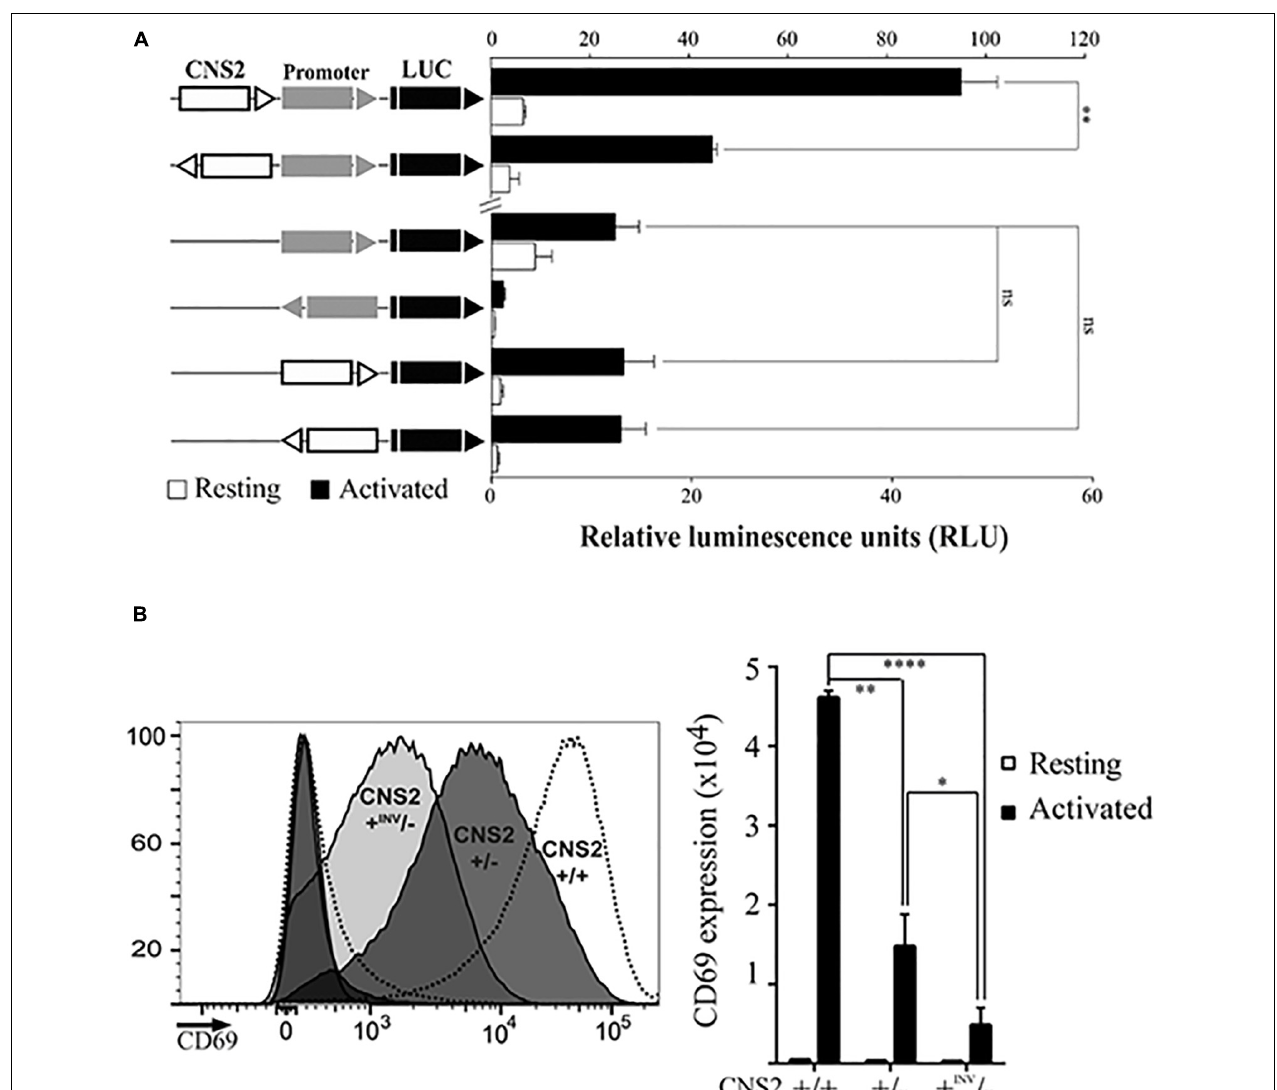
FIGURE 2 | CNS2 activity is partially orientation-independent. (A) Jurkat cells were transfected with luciferase constructs bearing the CD69 promoter and/or CNS2 regulatory elements in the indicated positions and orientations with respect to the luciferase ORF. Bars and error bars denote the mean ± standard error of the mean (SEM), respectively, of relative luminescence units from three individual experiments, being the value of each experiment the mean of two technical duplicates. (B) Left. Histograms of CD69 surface expression 24 h post-activation in representative CNS2 ± (dark gray) and CNS2 + inv /- (light gray) clones. Histograms of non-activated and activated wild type controls are represented as dashed lines. Right. MFI of CD69 surface expression in two independent CNS2 ± clones and four CNS2 inv /- clones in basal conditions (white) or 24 h post-activation (black). Mean ± SEM of CD69 MFI of the various assayed clones are shown. ns: non-significant, * p < 0.05, ** p < 0.01, *** p < 0.001, **** p <